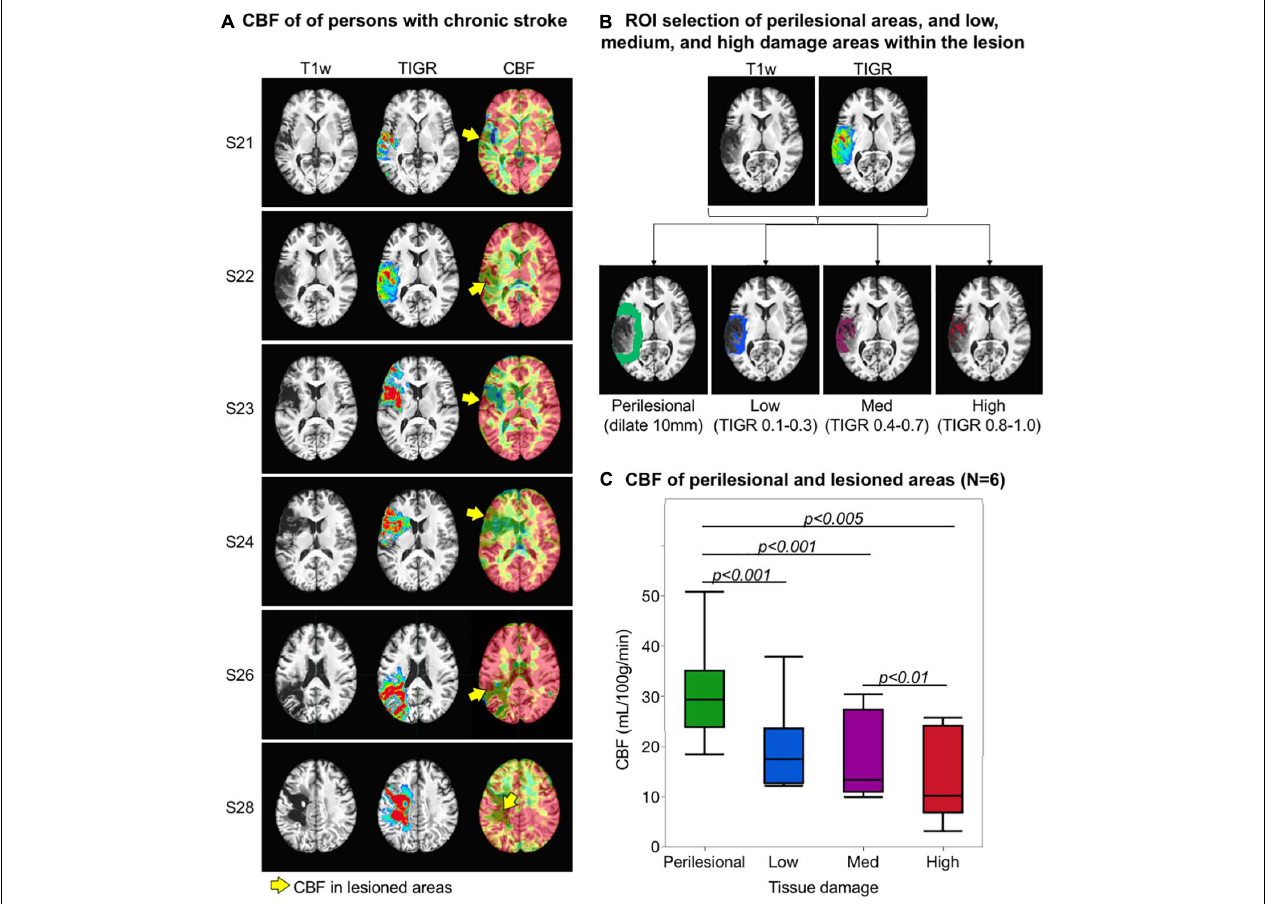
FIGURE 3 | Validation of tissue integrity gradation via T2w T1w ratio (TIGR) using cerebral blood flow (CBF) maps. (A) The T1w image, TIGR map, and corresponding CBF map from six chronic stroke participants. The yellow arrows highlight the perfused pericavitational areas. (B) The region of interest selection of a representative individual (see text for description). (C) Pericavitational areas present with a significantly lower blood flow than the perilesional areas, where high damage areas have the lowest quantified CBF.